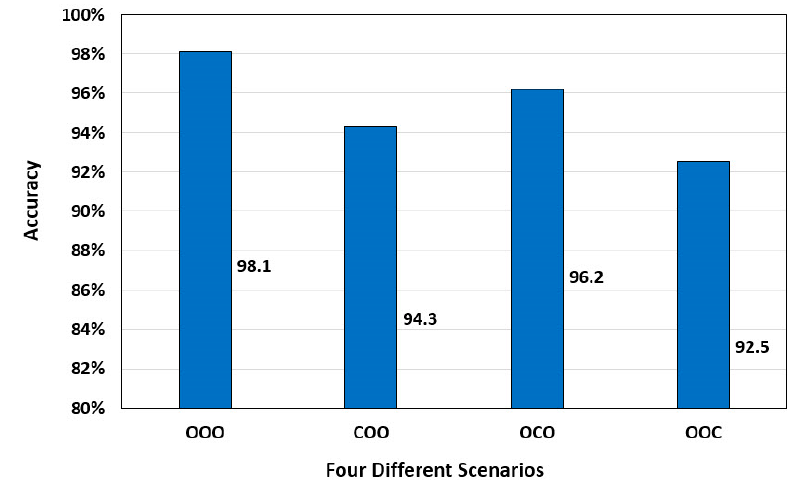
Figure 10. The accuracies of four different data sets analyzing network in the steady-state conditions.